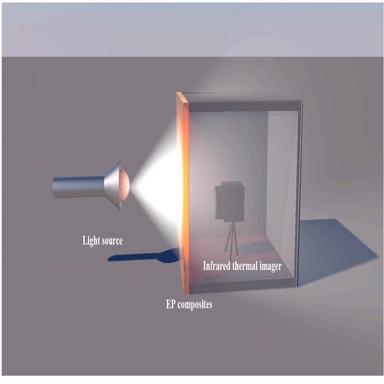
Schematic diagram of infrared thermal imager testing experiment.